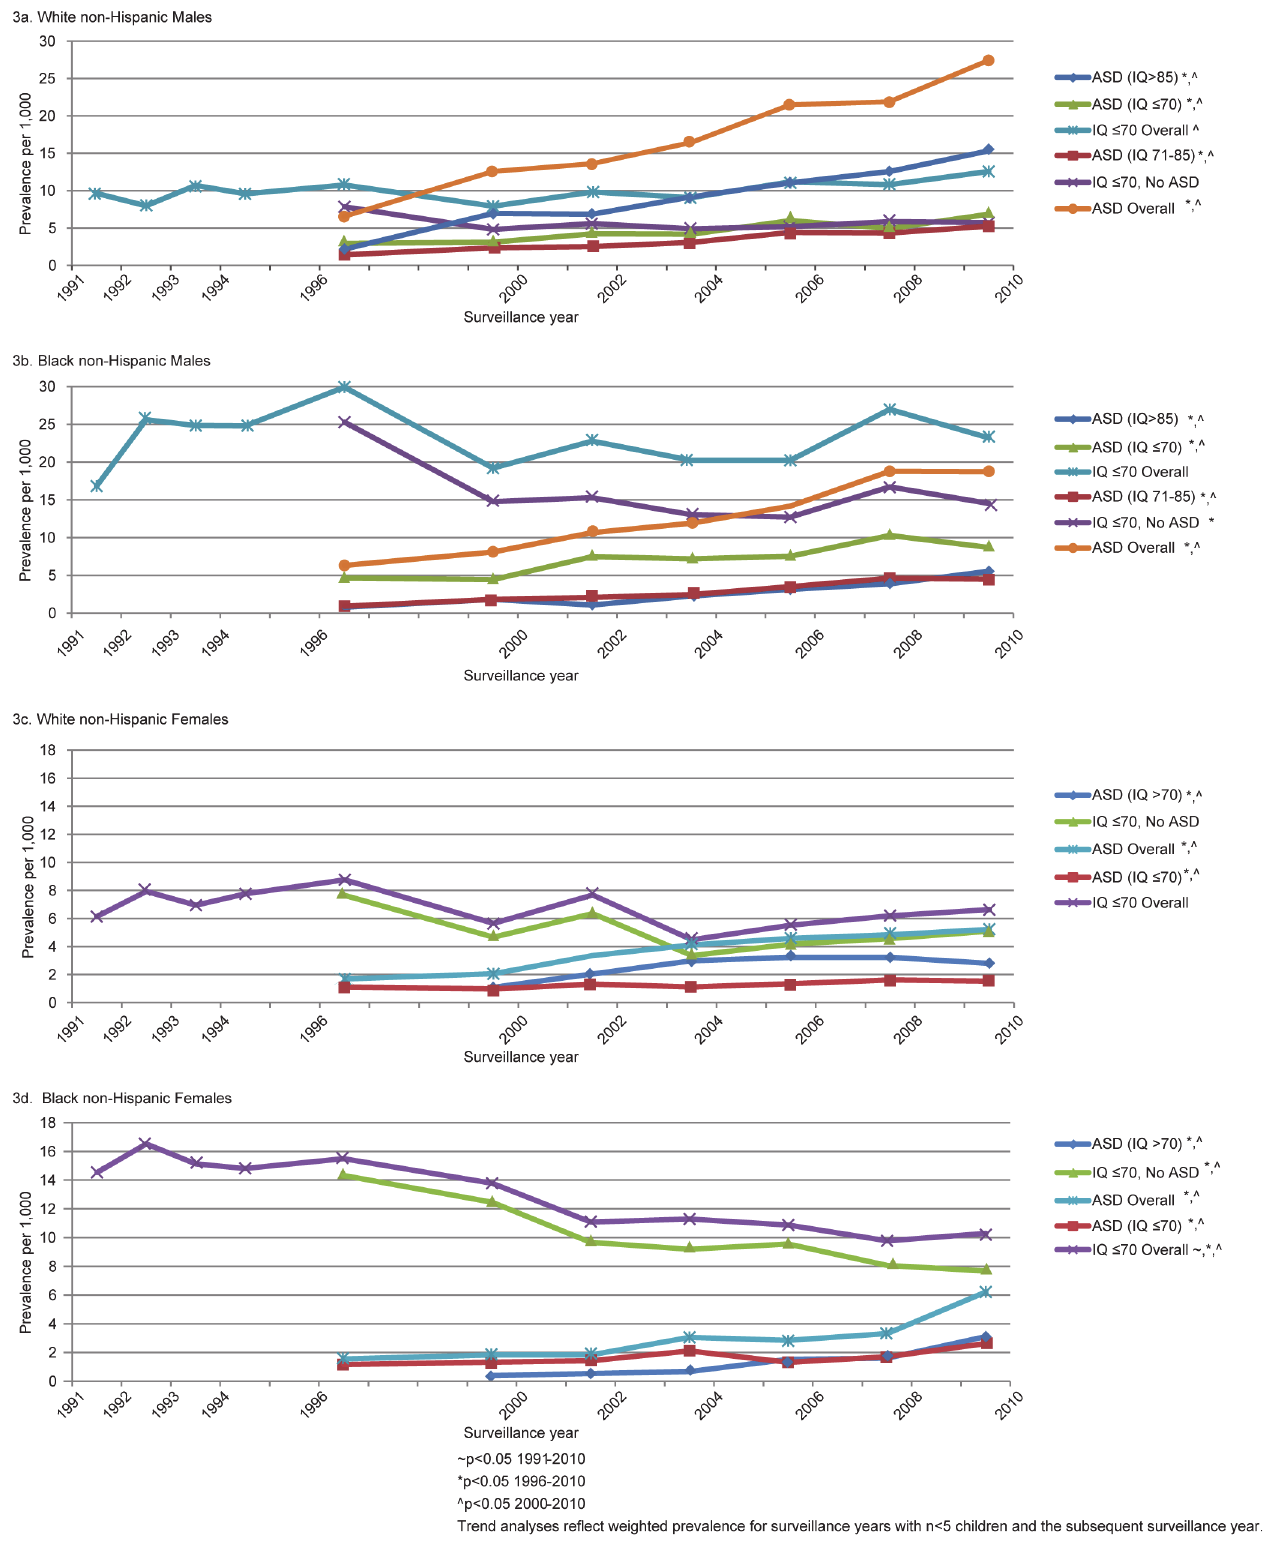
Fig 3. Prevalence of Co-occurring Intellectual Ability and Autism Spectrum Disorder by Sex and Race/ethnicity, 1991 – 2010.